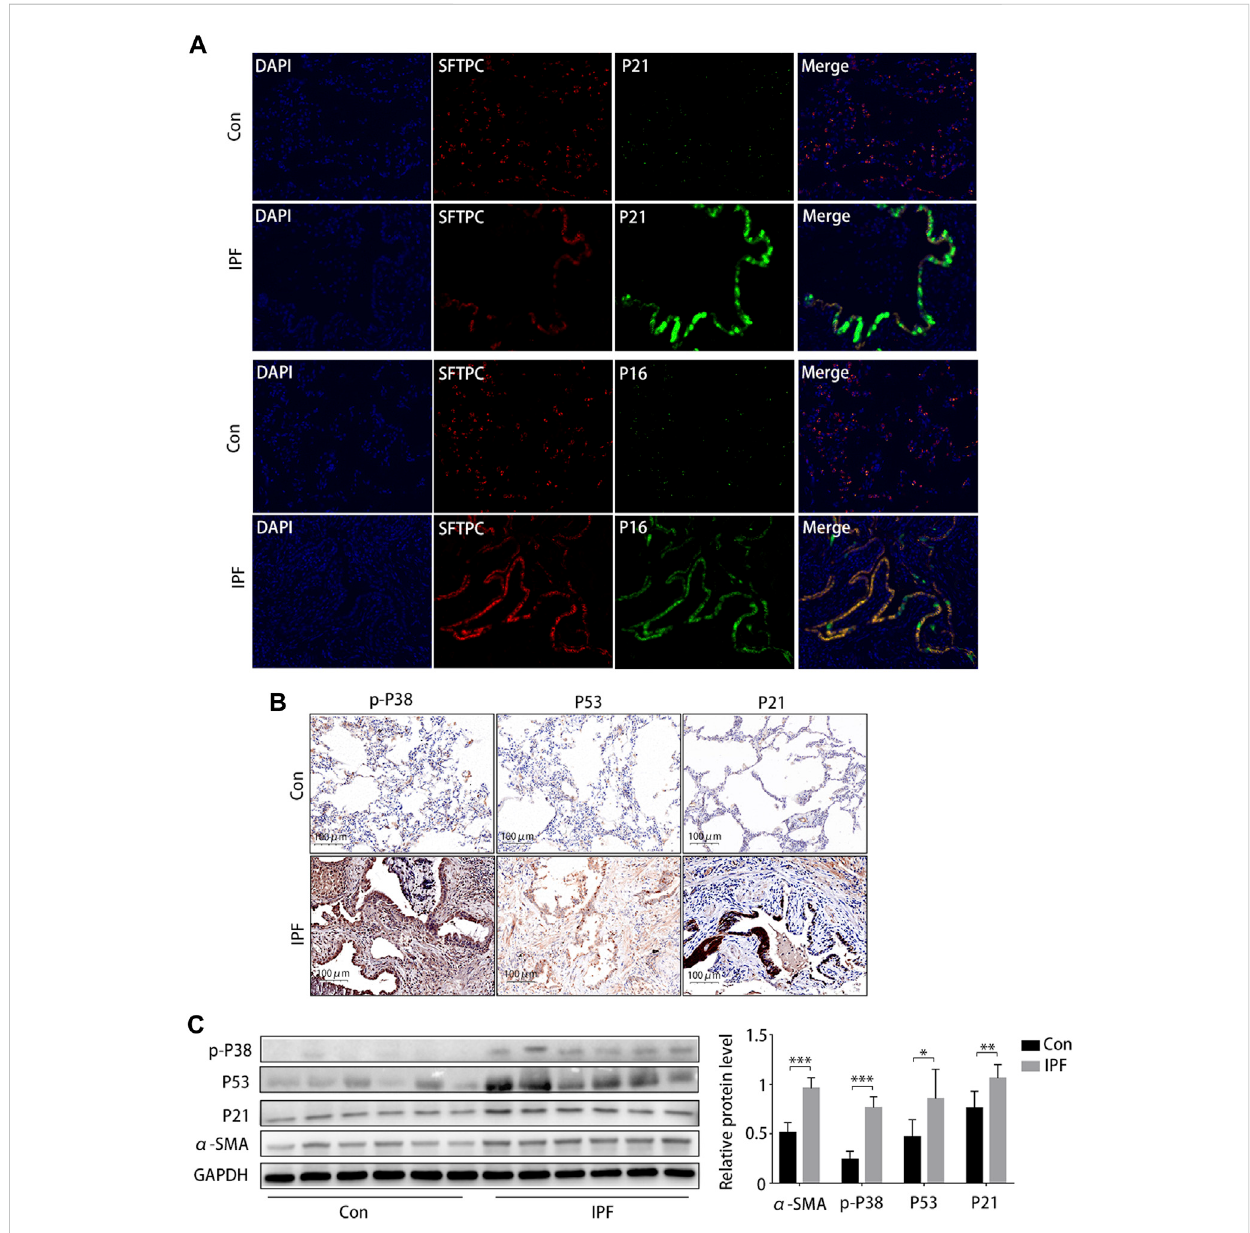
FIGURE 6 Activated p38/p53/p21 pathway in lung tissue from patients with idiopathic pulmonary fi brosis (IPF). (A) Immuno fl uorescence staining of SFTPC (an AEC2-speci fi c marker, red), p21 (green), and p16 (green) to con fi rm the expression of increased senescent markers in patients with IPF (original magni fi cation, ×400). (B) Representative results of immunohistochemical staining for p-p38, p53, and p21 in the lungs of patients with IPF and normal lungs (scale bar, 50 μ m). (C) Western blot of p-p38, p53, and p21 expression. * p < 0.05, ** p < 0.01, *** p <